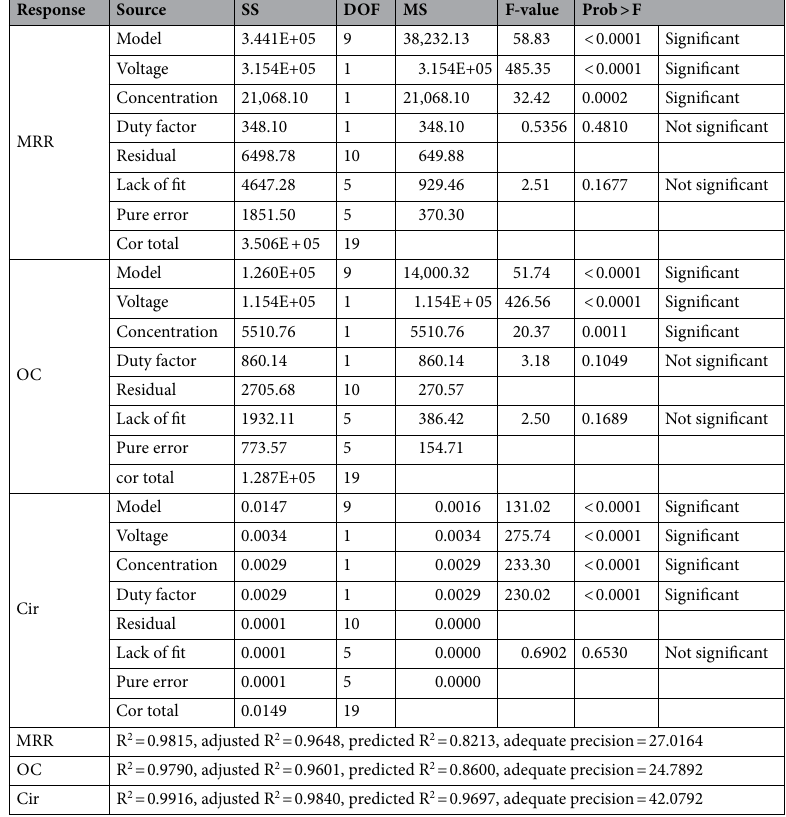
Table 3. ANOVA of the machining